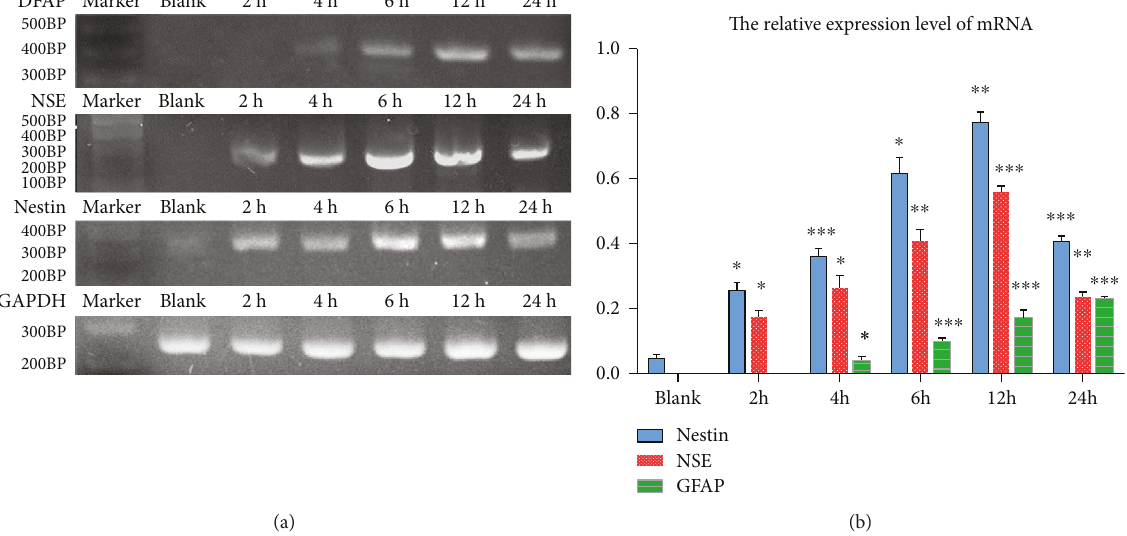
Figure 7: (a) Result of semiquantitative RT-PCR. (b) Relative expression level of mRNA.